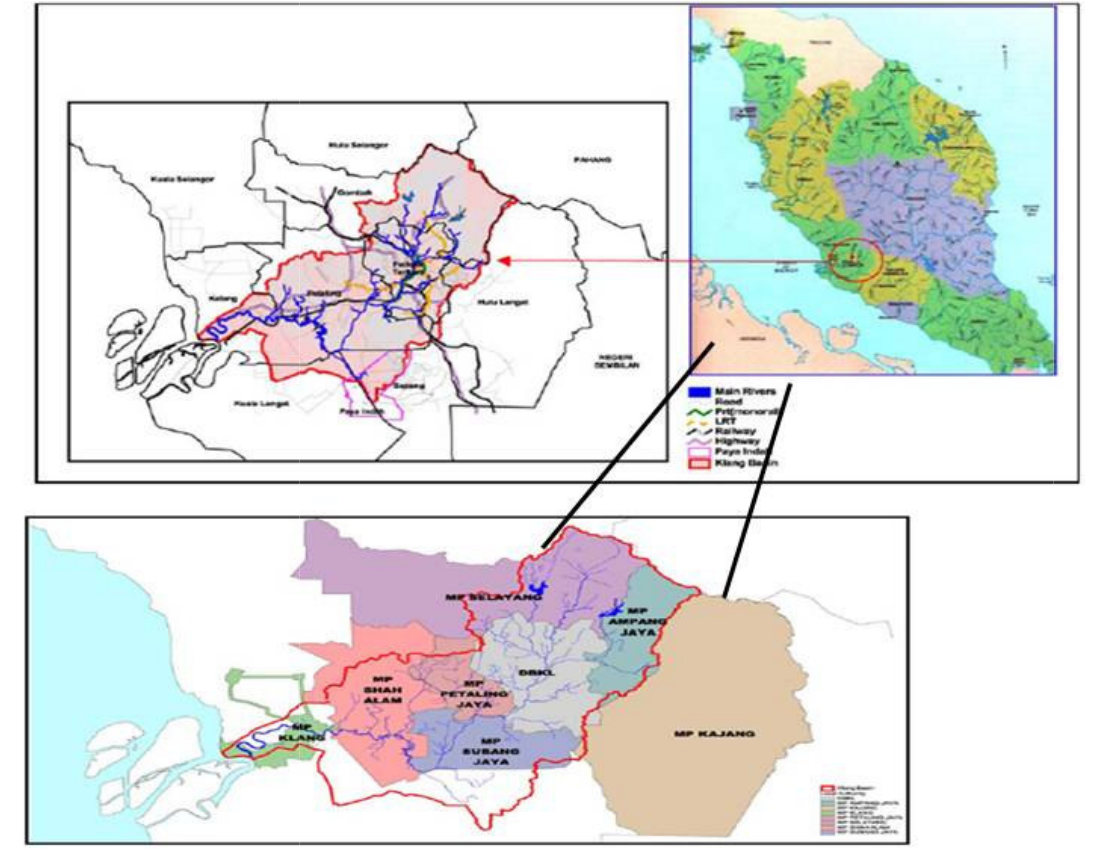
Fig. 6. Local authorities within Klang River